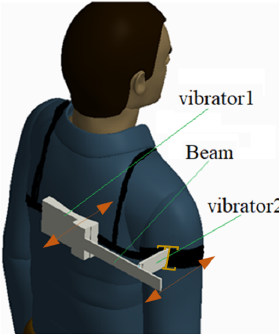
Figure 1. Schematic diagram of a piezoelectric energy harvester for human body motion subjected to two excitations.